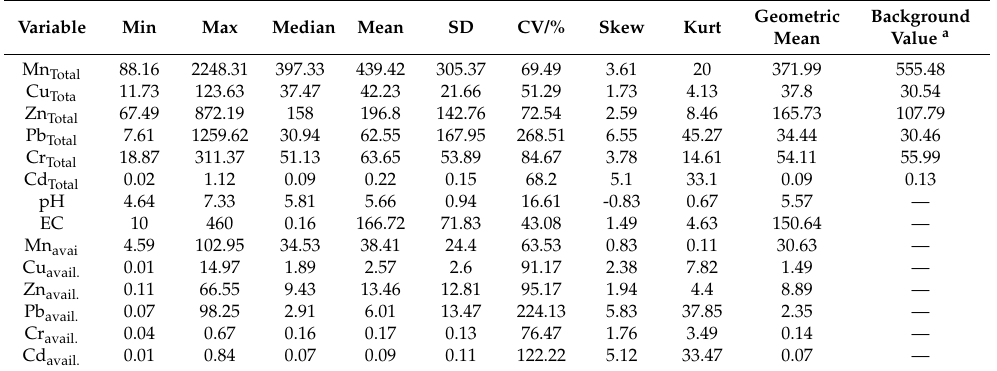
Table 1. Descriptive statistics of physical-chemical properties and PHMs in soils (mg · kg − 1 ; EC: µ S · cm − 1 ).